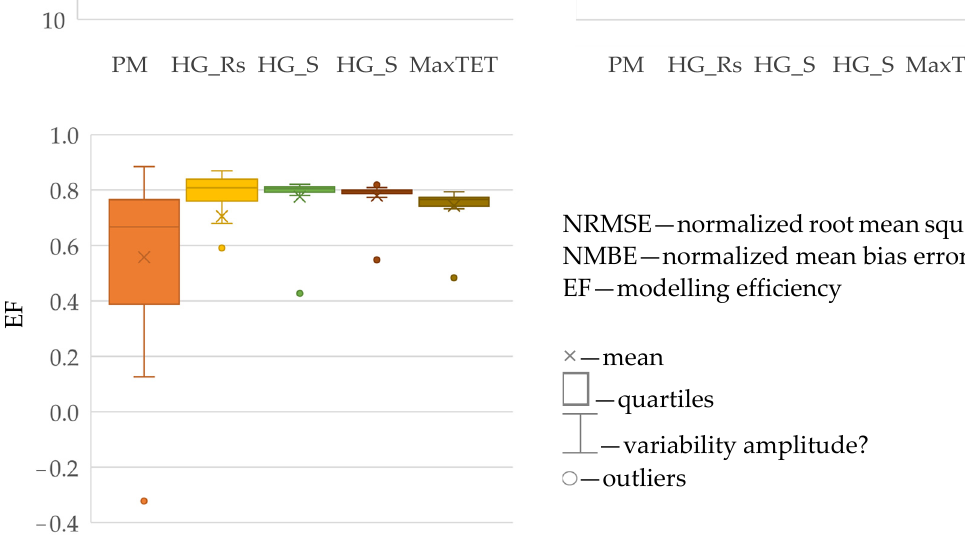
Figure 1. Box plots (Box and whiskers) of normalized root mean square error, normalized mean bias error and modelling